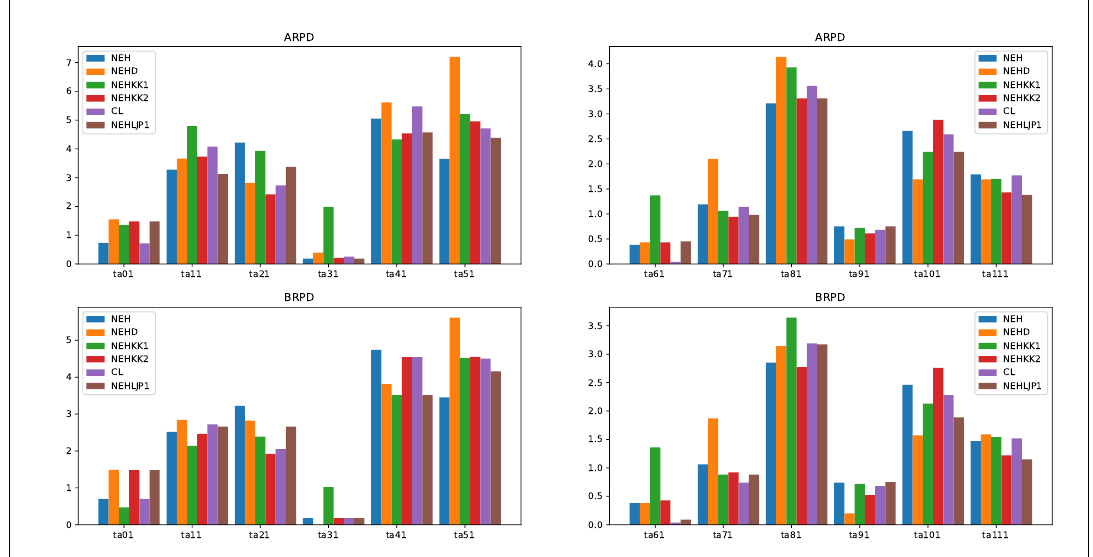
Figure 3. Comparison of the results for all different NEH-based algorithms. Table 6. Comparison of different iterations of the local search for small job sizes. 1000 jobs × ( jobs − 1